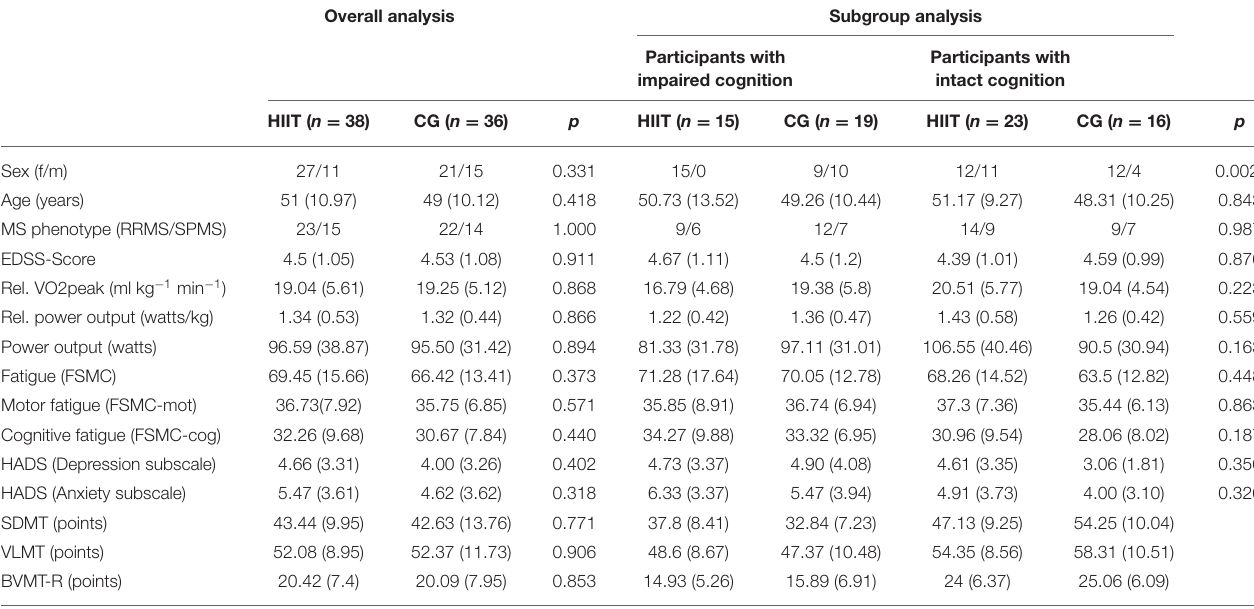
TABLE 1 | Baseline characteristics of the participants.